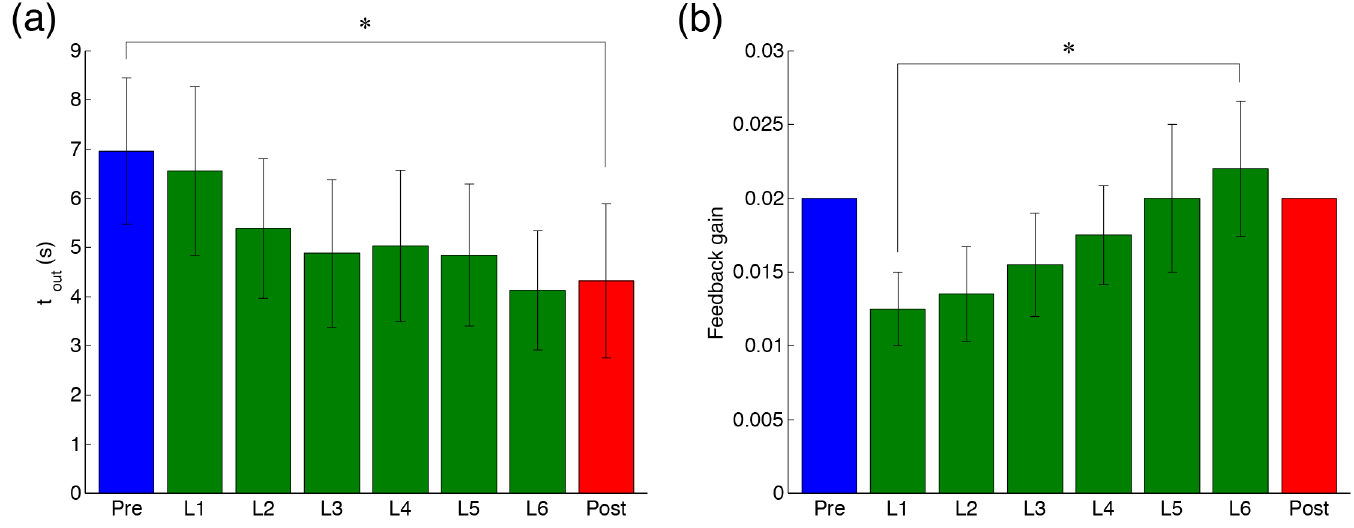
Fig 8. Change in the tracking performance through motor learning. (a) The duration of out of margin t out . (b) The feedback gain G (Eq (11)). The blue, green and red bars indicate the pre-test, the learning phases, and the post-test, respectively. The asterisk indicates a significant difference ( P < 0.05). Specific values are listed in S3